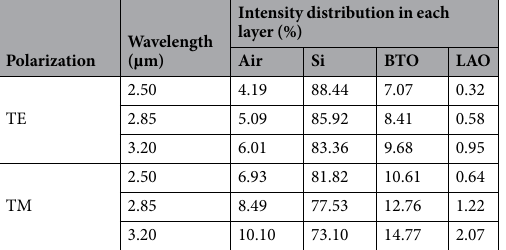
Table 1. The intensity distribution of a Si-on-BTO waveguide, which consists of up-cladding air, a-Si waveguide, BTO undercladding, and LAO substrate. The distributions were calculated at two polarizations, TE and TM, and three different wavelengths of λ = 2.50 µ m, 2.85 µ m, and 3.20 µ m.